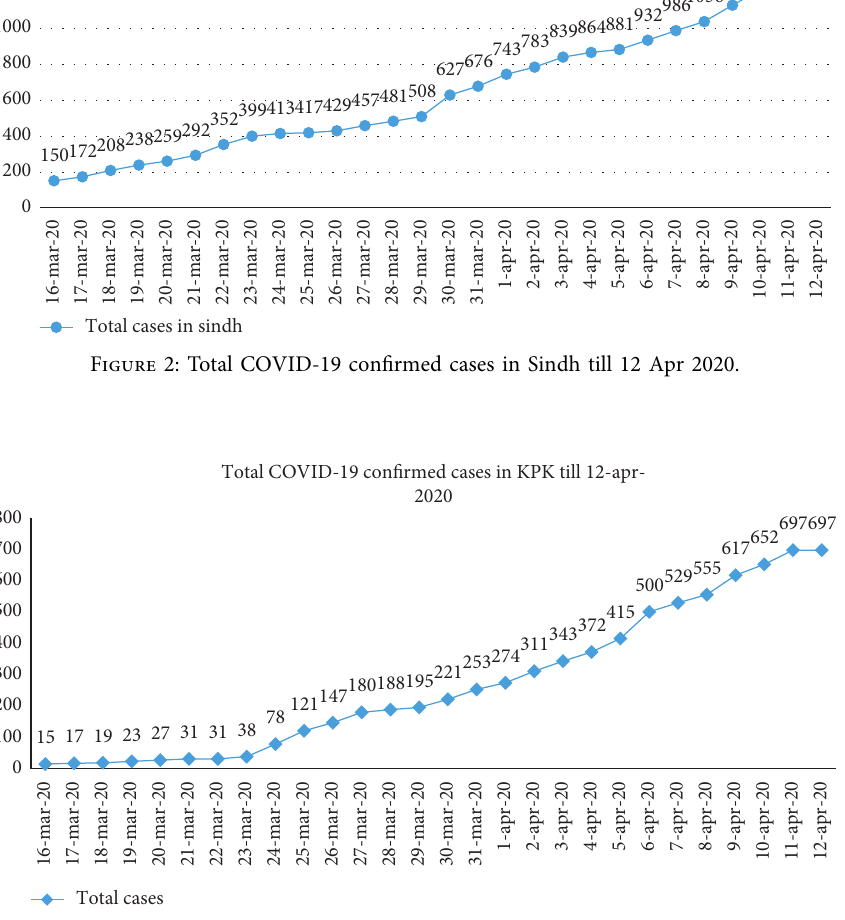
Figure 3: Total COVID-19 confirmed cases in KPK till 12 Apr